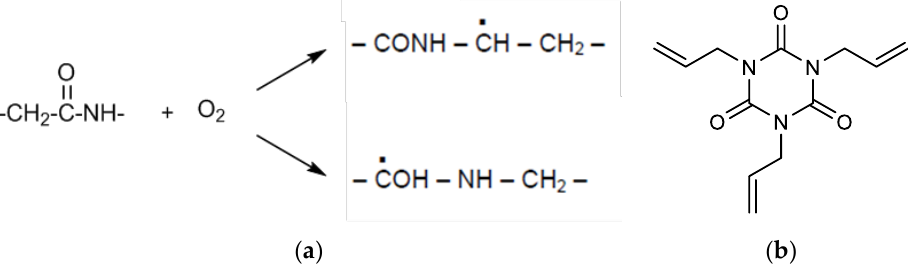
Figure 1. ( a ) Schematic illustration of the radical formation for a polyamide and ( b ) the chemical structure of the irradiation additive TAIC.